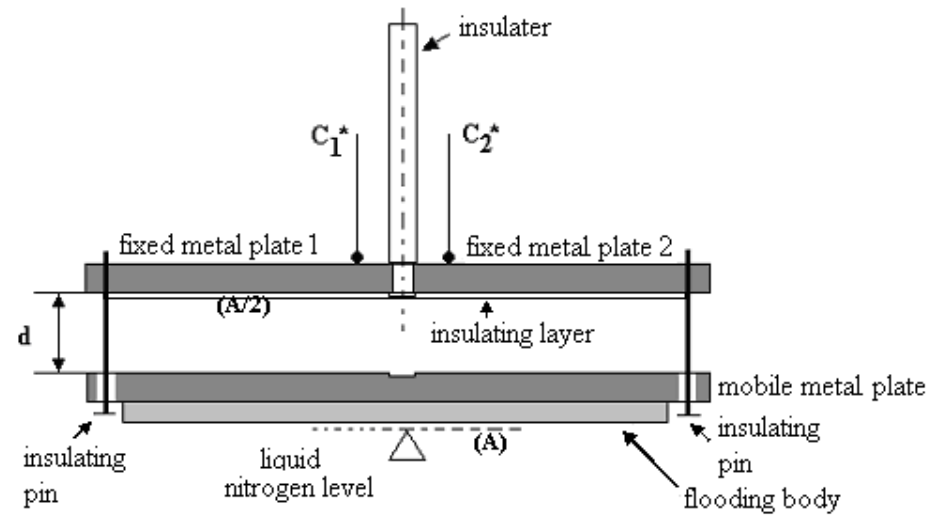
Figure 6. Section of capacitive-level sensor.